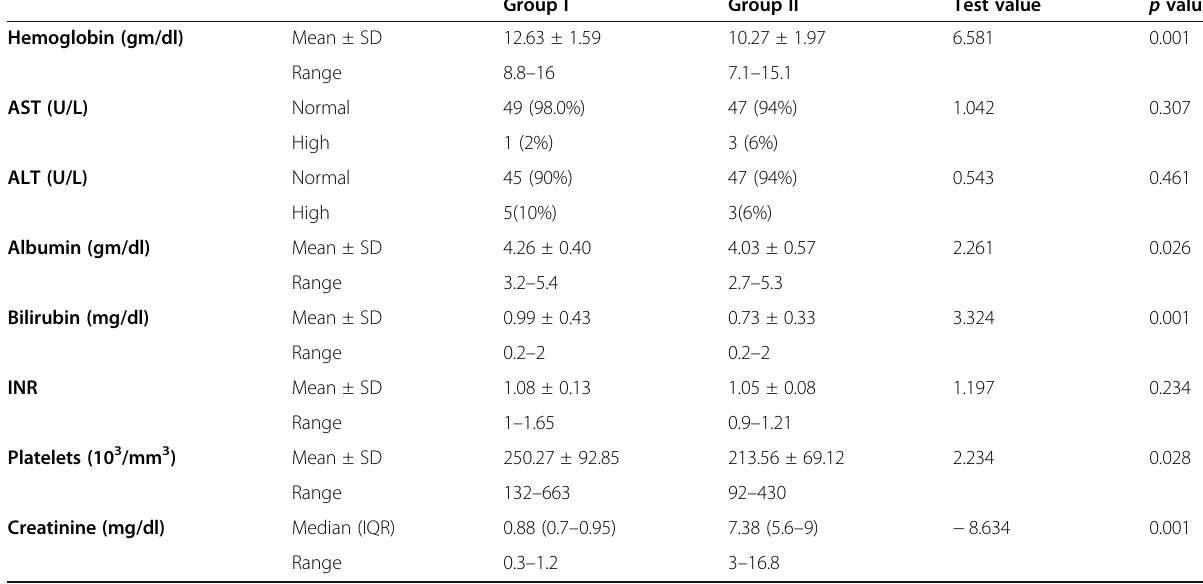
Table 4 Comparison between group I (control group) and group II (case group) regarding levels of hemoglobin, AST, ALT, albumin, total bilirubin, INR, platelets, and creatinine 4 weeks after